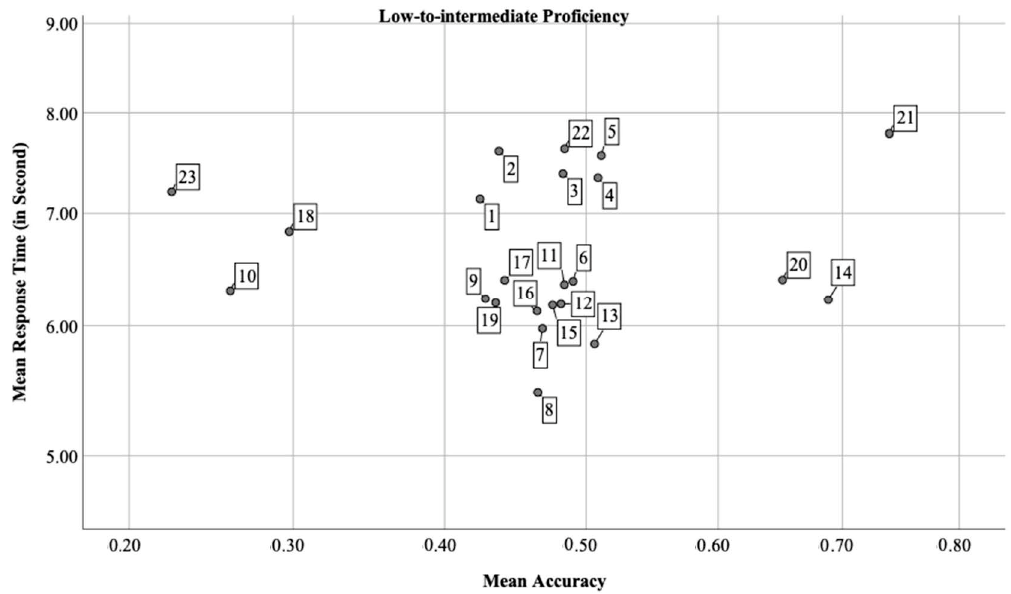
Figure 2. Scatterplot of cues (accuracy by response time) in the low-to-intermediate group.